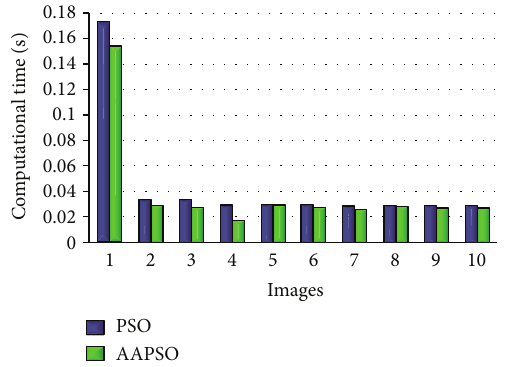
Figure 9: The computation time of AAPSO-SVM and PSO-SVM.